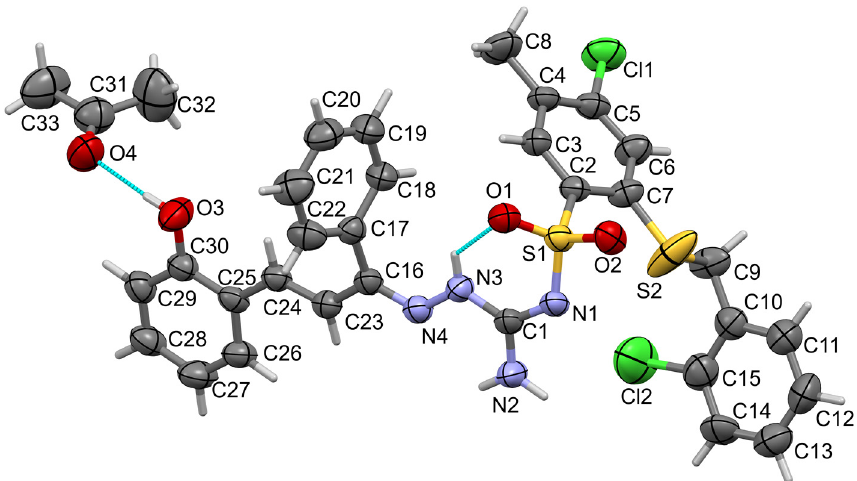
Figure 2. Molecular structure of 24 showing atom labeling scheme and hydrogen bonding shown as cyan dashed lines. Second part of disordered S2-C9-C15-Cl2 group is omitted. Displacement ellipsoids are shown at 50% probability. Selected bond lengths (Å) and angles (°): C1-N1 1.334(4), C1=N2 1.326(4), C1-N3 1.348(4), N3-N4 1.382(4), N4-C16 1.289(4), S1-N1 1.594(3), S1-C2 1.787(3), C16-C23 1.452(5), C23-C24 1.332(5), O3-C30 1.361(4), O4=C31 1.218(6), N1-S1-C2 108.44(16), C7-S2-C9 104.2(4). For parameters of hydrogen bonding see S.3 (Supplementary Material).